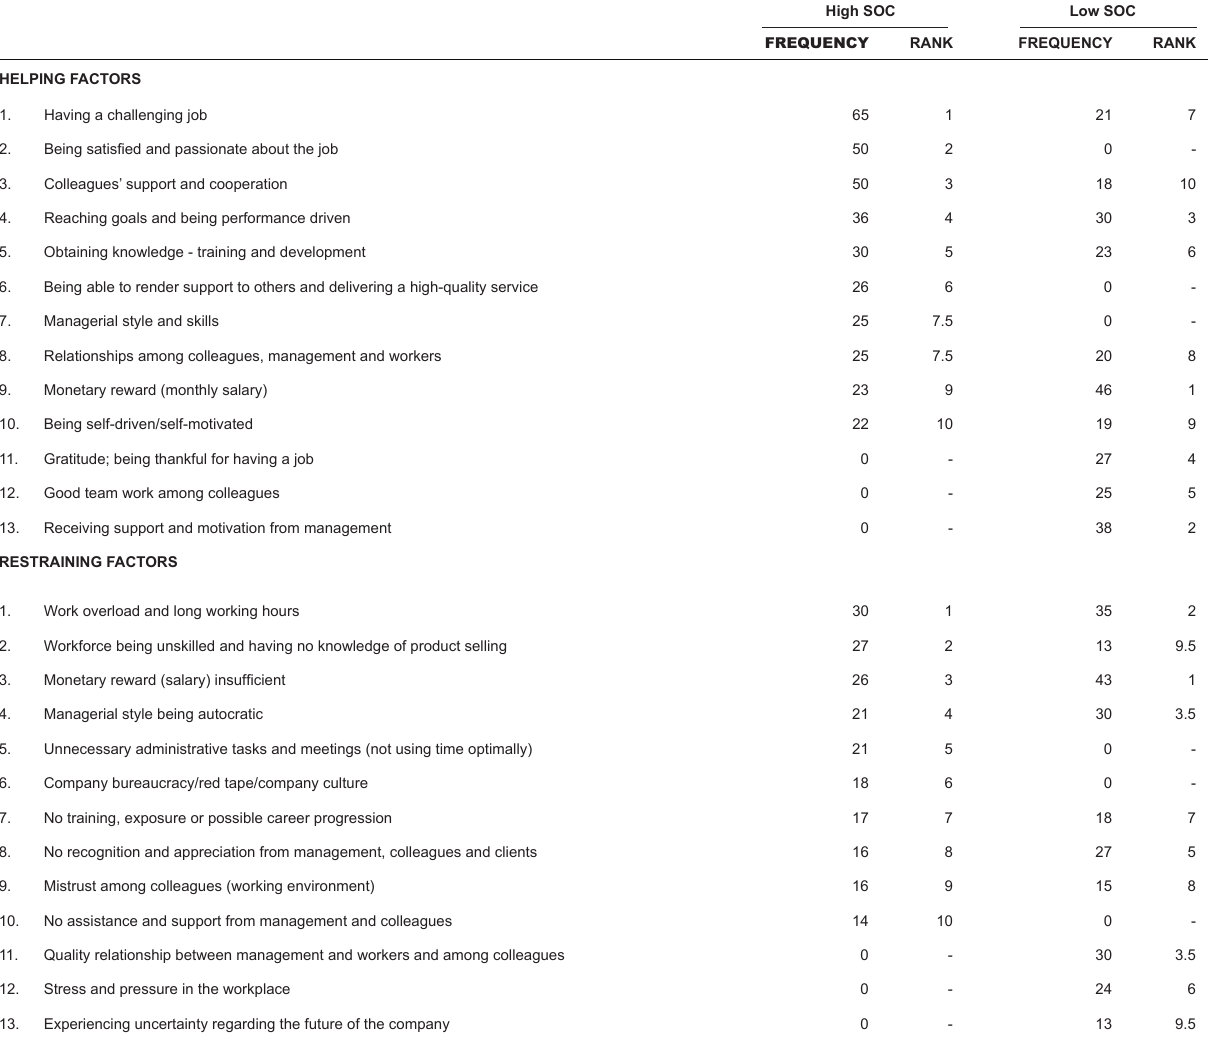
Perceptions of helping and restraining factors of employees with high and low scores on sense of coherence (SOC)